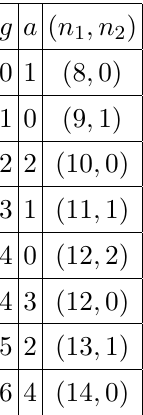
Table 2. Shrinkable surfaces S = F g engineering G 2 + N F F gauge theories. The surface n 1 [ F n 2 is a ruled surface over a curve E with g ( E ) = N F and satisfying E 2 = F g n 1 C = S 1 S 2 is given by C S = E and C S = aF + 3 H . The (cid:12)ber classes are given by are f i = F i 1 2 \